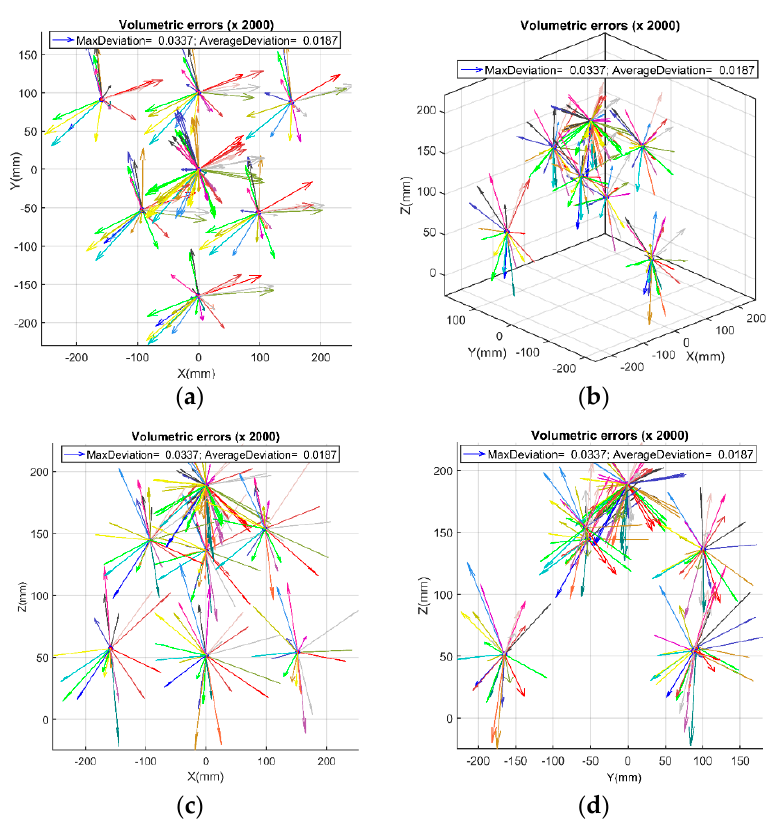
Figure 6. Plotted deviation between compensated artefact by SAMBA while considering one ball to model the tool and calibrated artefact for seven balls, estimated tool by probing one ball (item S2) (units are millimetre). ( a ) Deviation arrows, X-Y view, ( b ) 3-D view, ( c ) X-Z view, ( d ) Y-Z view